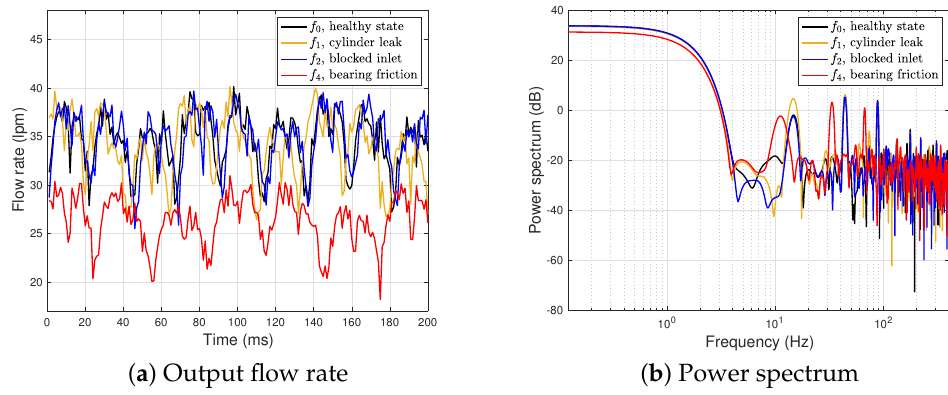
Figure 4. Output flow rate and power spectrum of f 0 , f 1 , f 2 , f 4 .